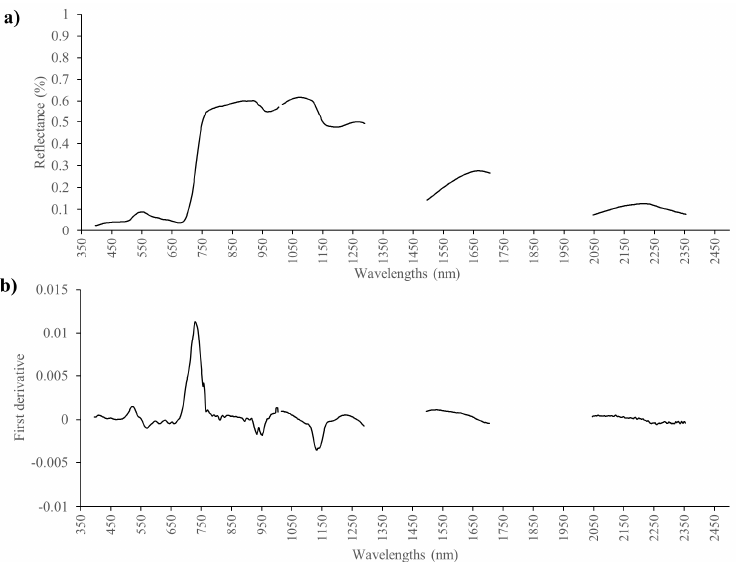
Figure 4. Typical canopy spectra (noisy atmospheric windows removed) for tef ( Eragrostis tef ) showing ( a ) Savitsky–Golay filtered reflectance curve and ( b ) first derivative (FD) transformation.